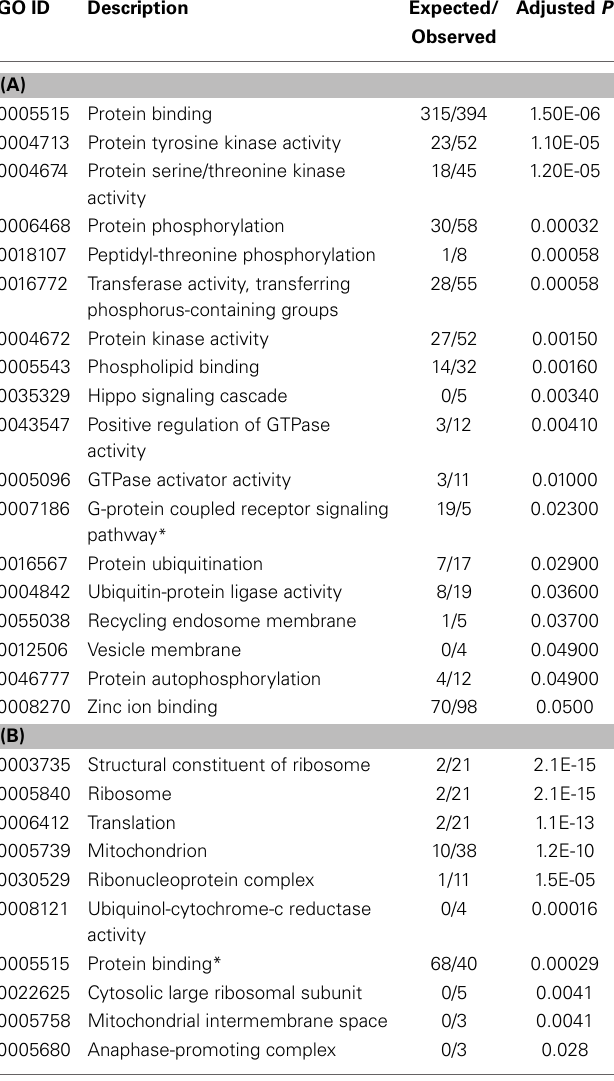
Table 3 | Gene Ontology (GO) analysis of the response to mir-2954 inhibition.